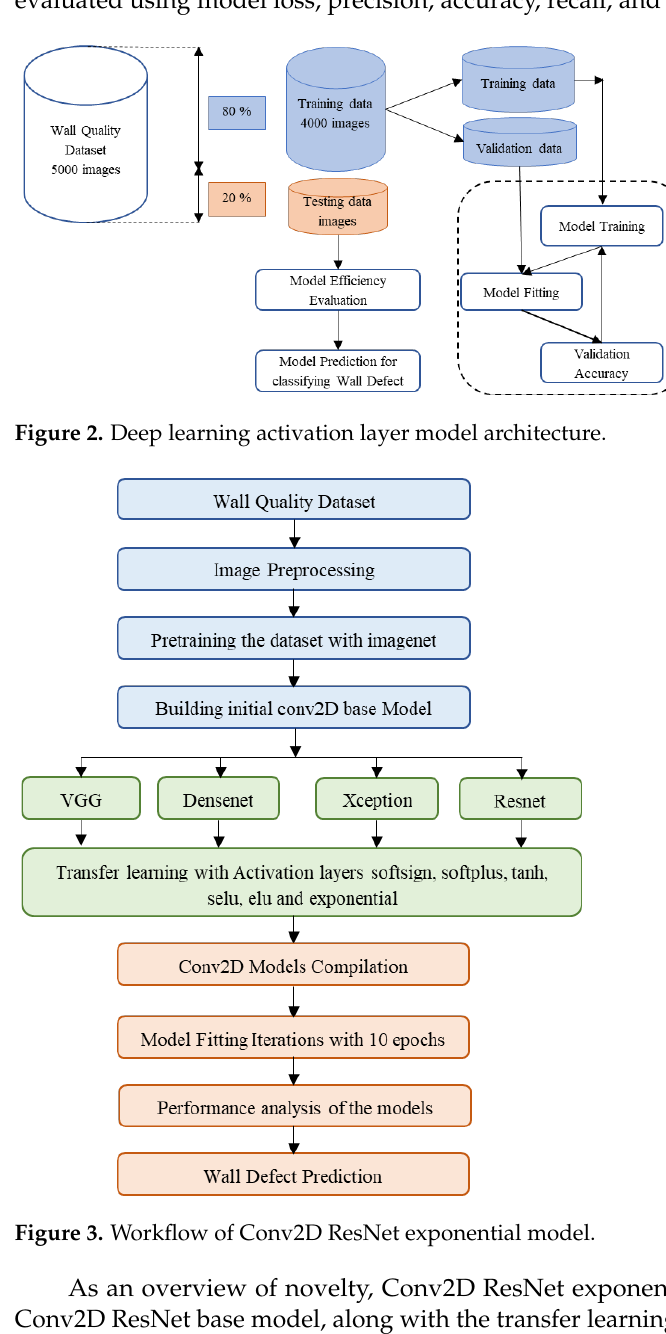
Figure 2. Deep learning activation layer model architecture.